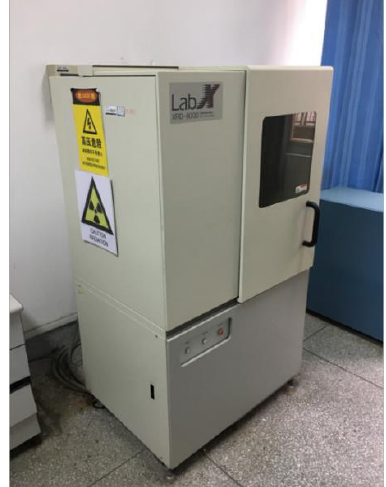
Figure 3. XRD-6000 model X-ray powder diffractometer.